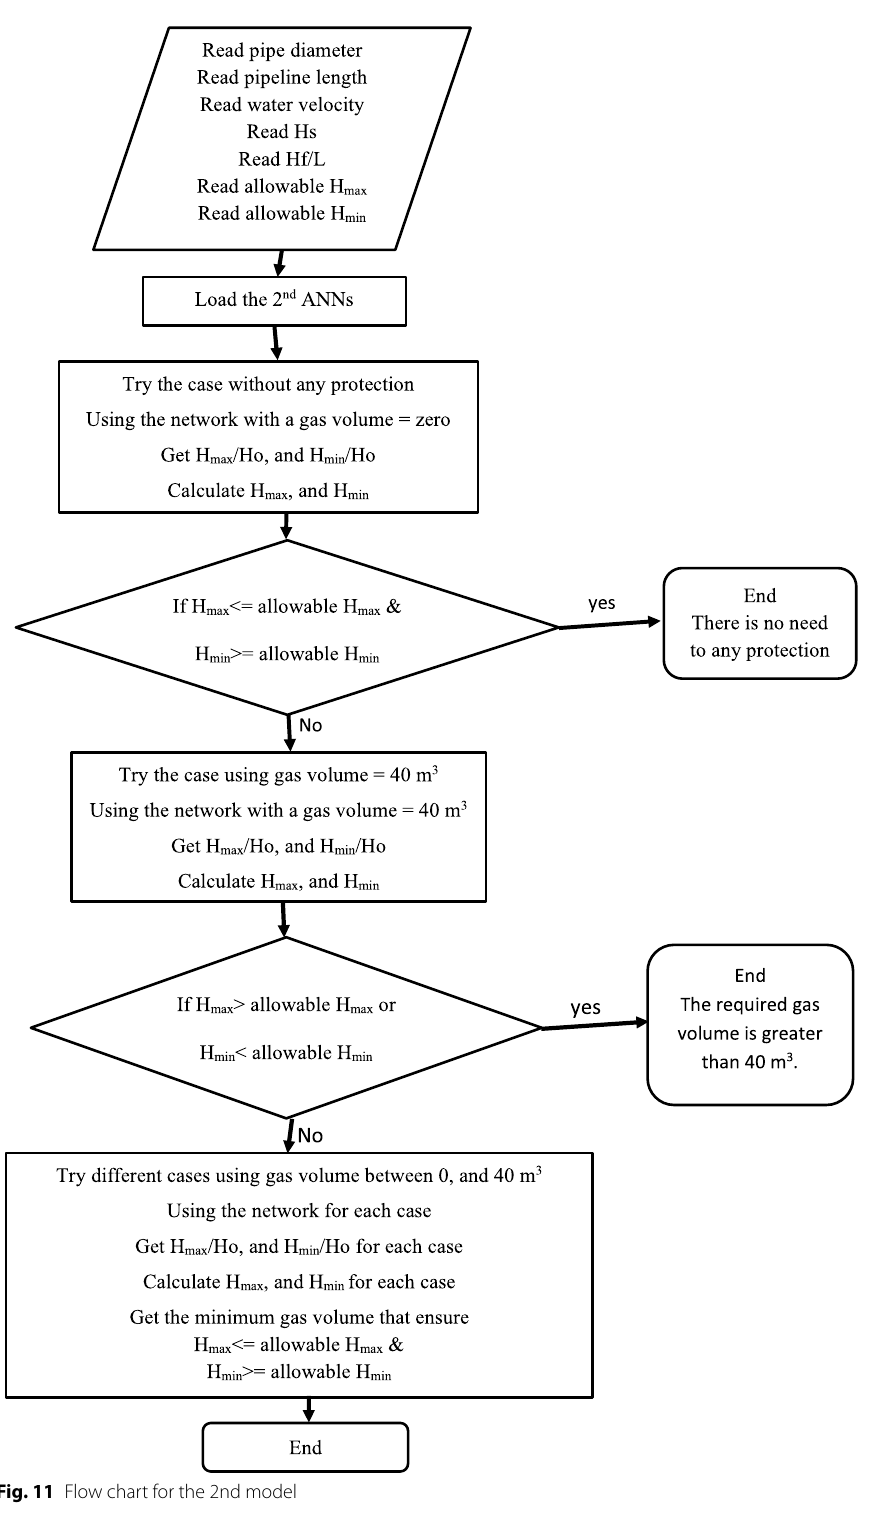
Fig. 11 Flow chart for the 2nd